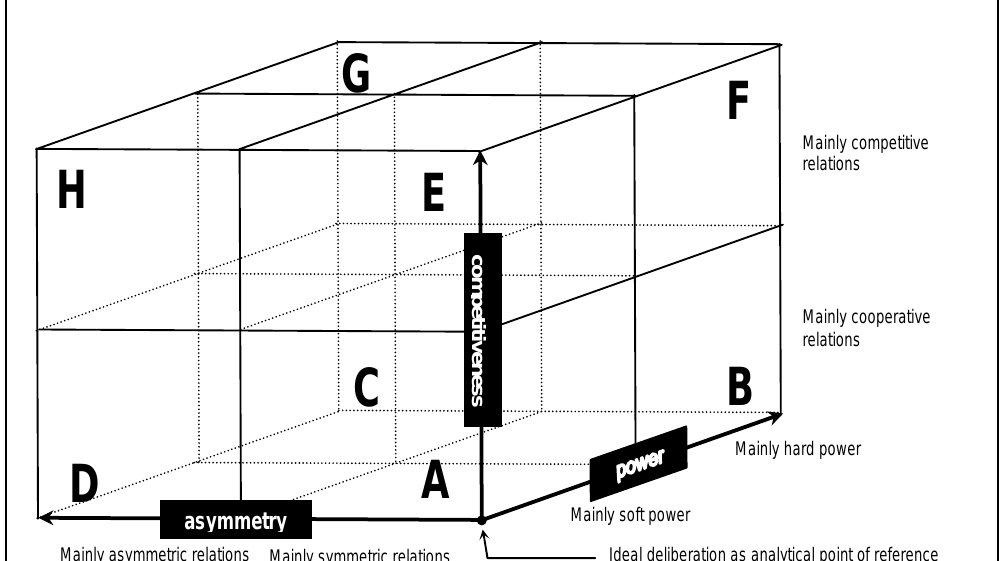
Figure 2 : The 3D-sphere of